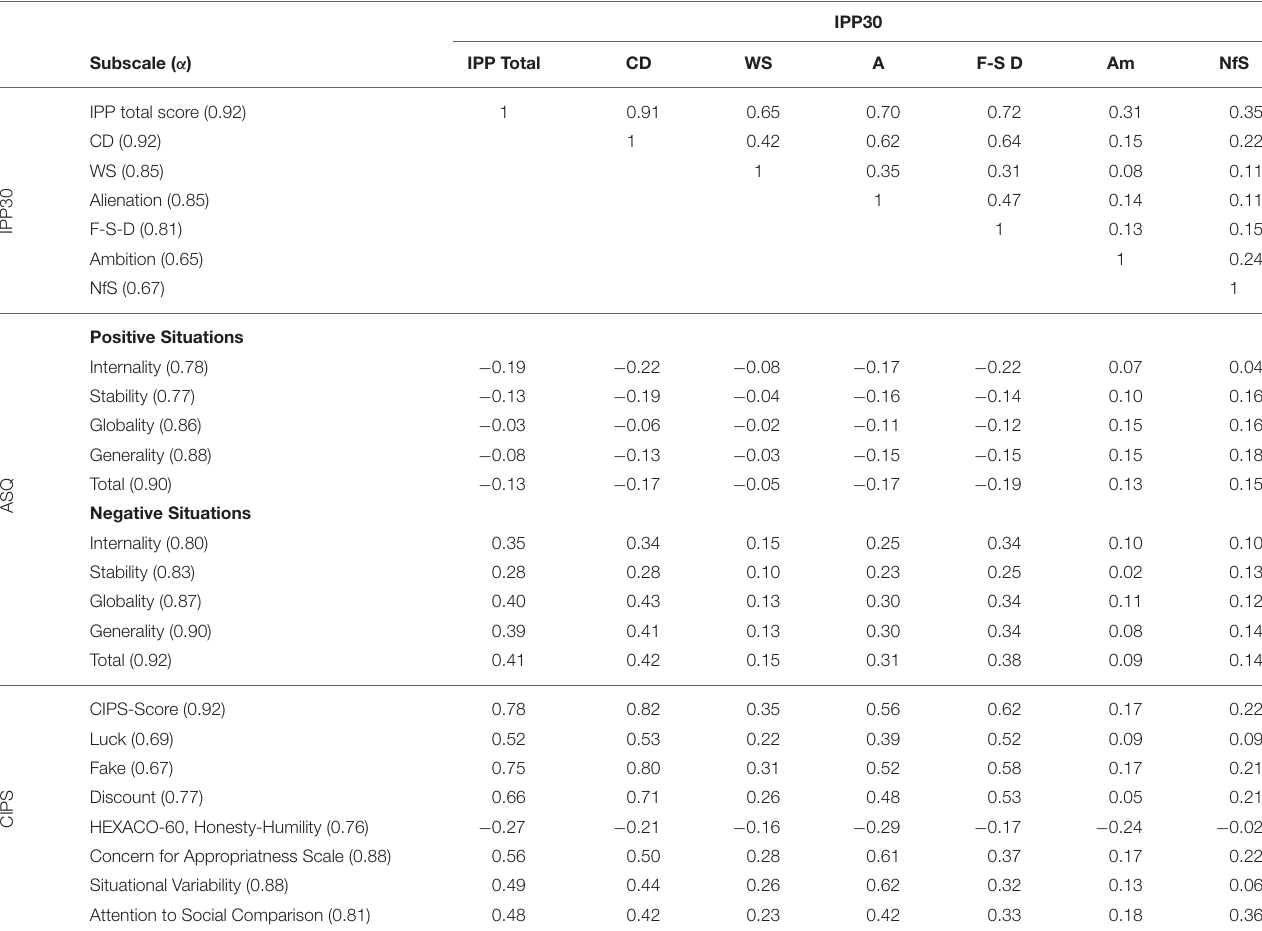
TABLE 5 | Correlations of the IPP30 scales and the Attributional Style Questionnaire (ASQ), Clance Impostor Phenomenon Scale (CIPS), HEXACO-60 scale Honesty-Humility and Concern for Appropriateness Scale